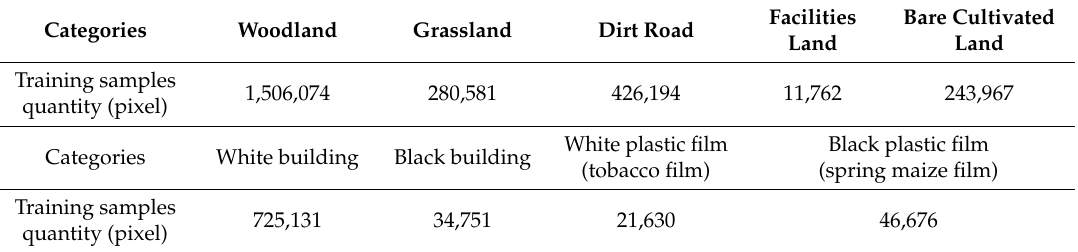
Table 2. Number of training samples for di ff erent feature